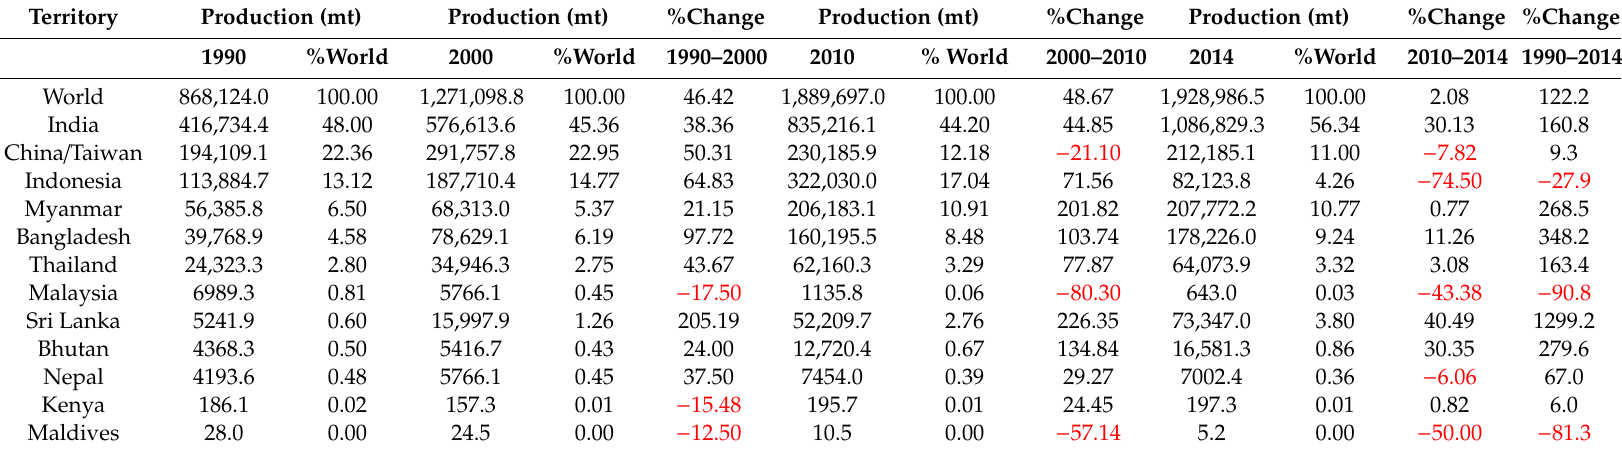
Table 1. Areca nut production by country,